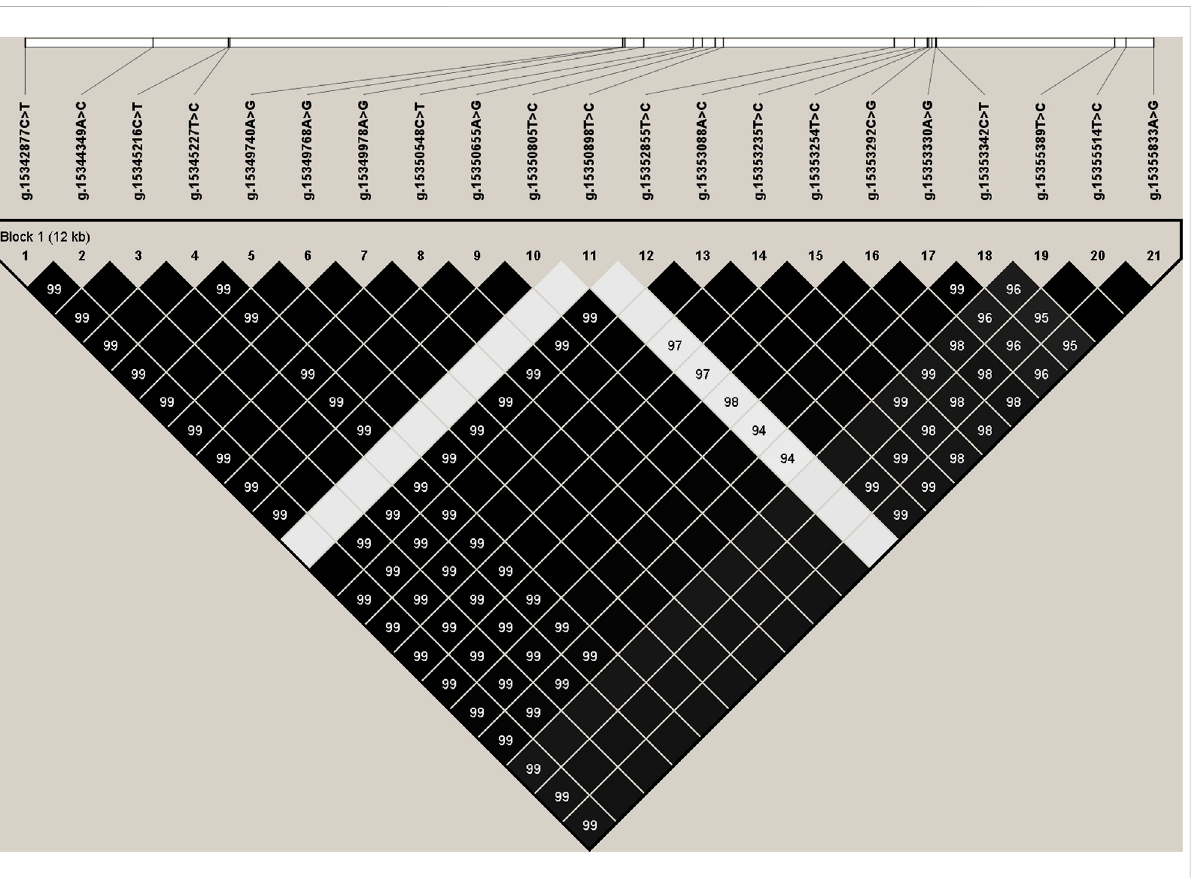
FIGURE 1 Linkage disequilibrium estimated between SNPs in PKLR gene. The values in the black boxes are pair-wise SNP correlations ( R 2